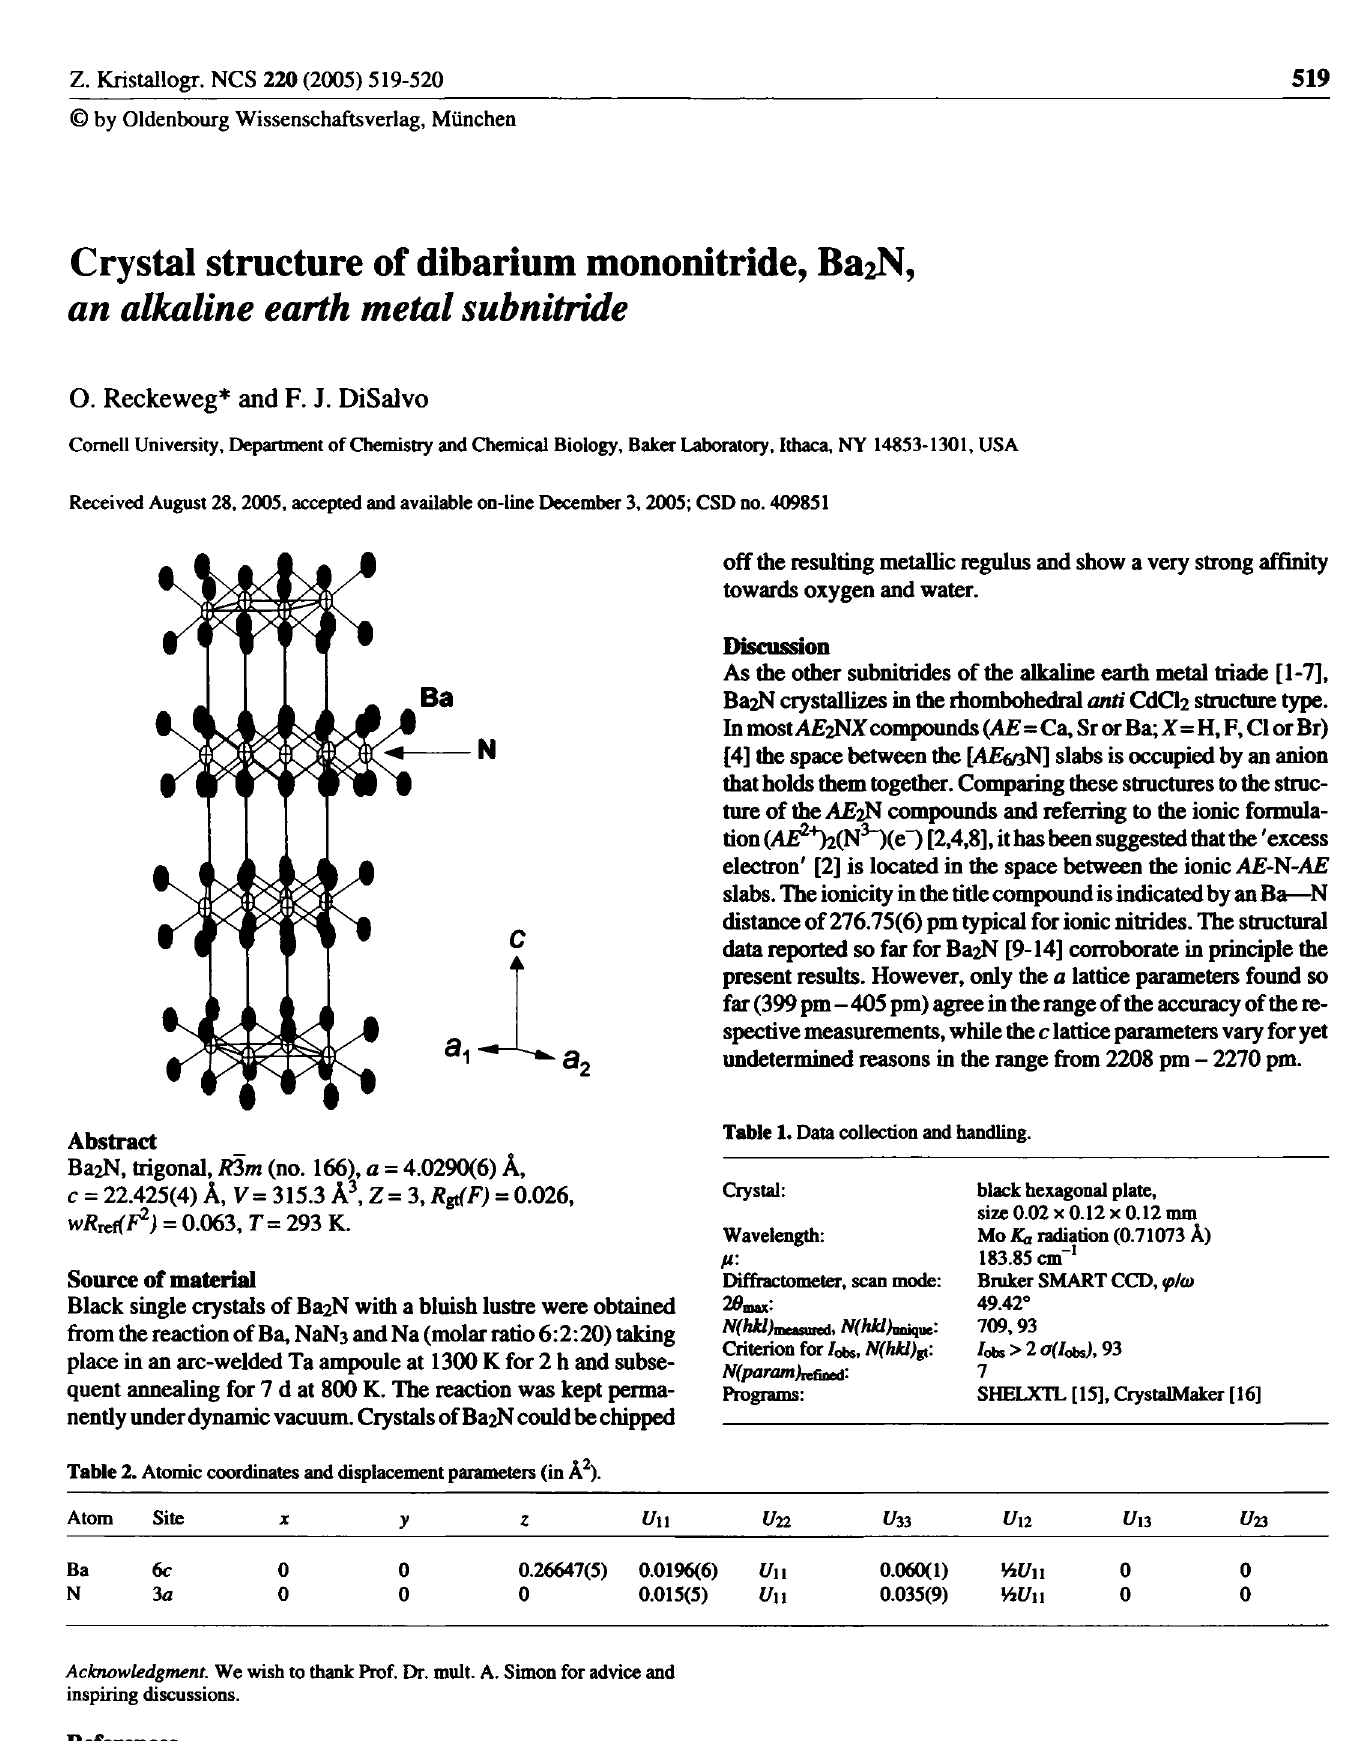
Table 2. Atomic coordinates and displacement parameters (in Ä 2